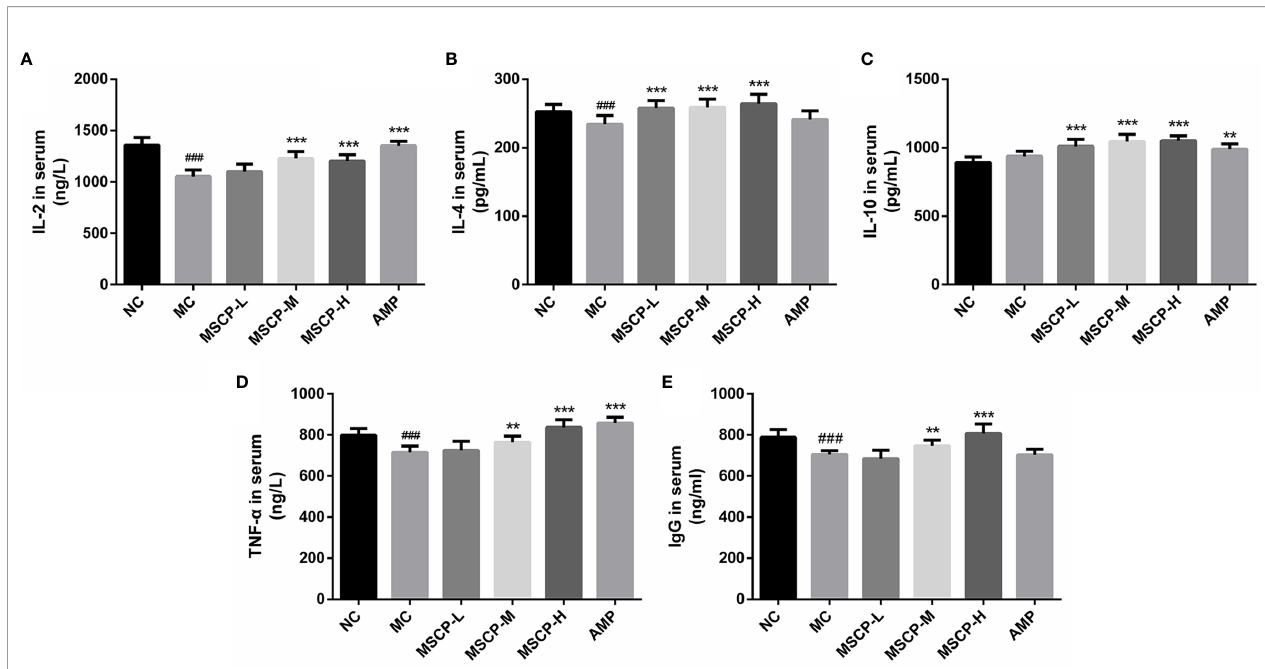
FIGURE 4 | Effects of MSCP on the levels of IL-2 (A) , IL-4 (B) , IL-10 (C) , TNF- a (D) and IgG (E) in serum of mice. Data are expressed as mean ± SD. ### p < 0.001 compared with NC group; ** p < 0.01, *** p < 0.001 compared with MC